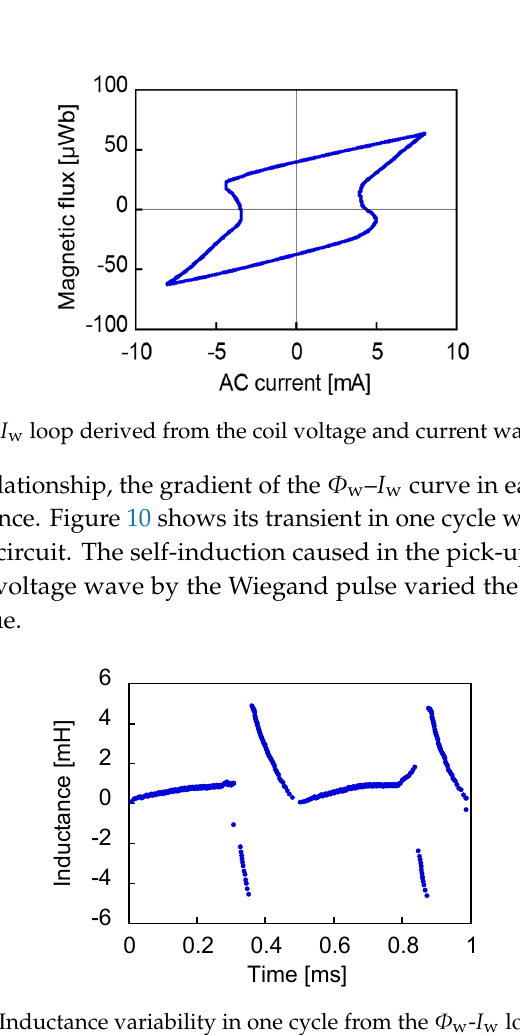
Figure 10. Inductance variability in one cycle from the Φ w - I w loop (1 kHz).